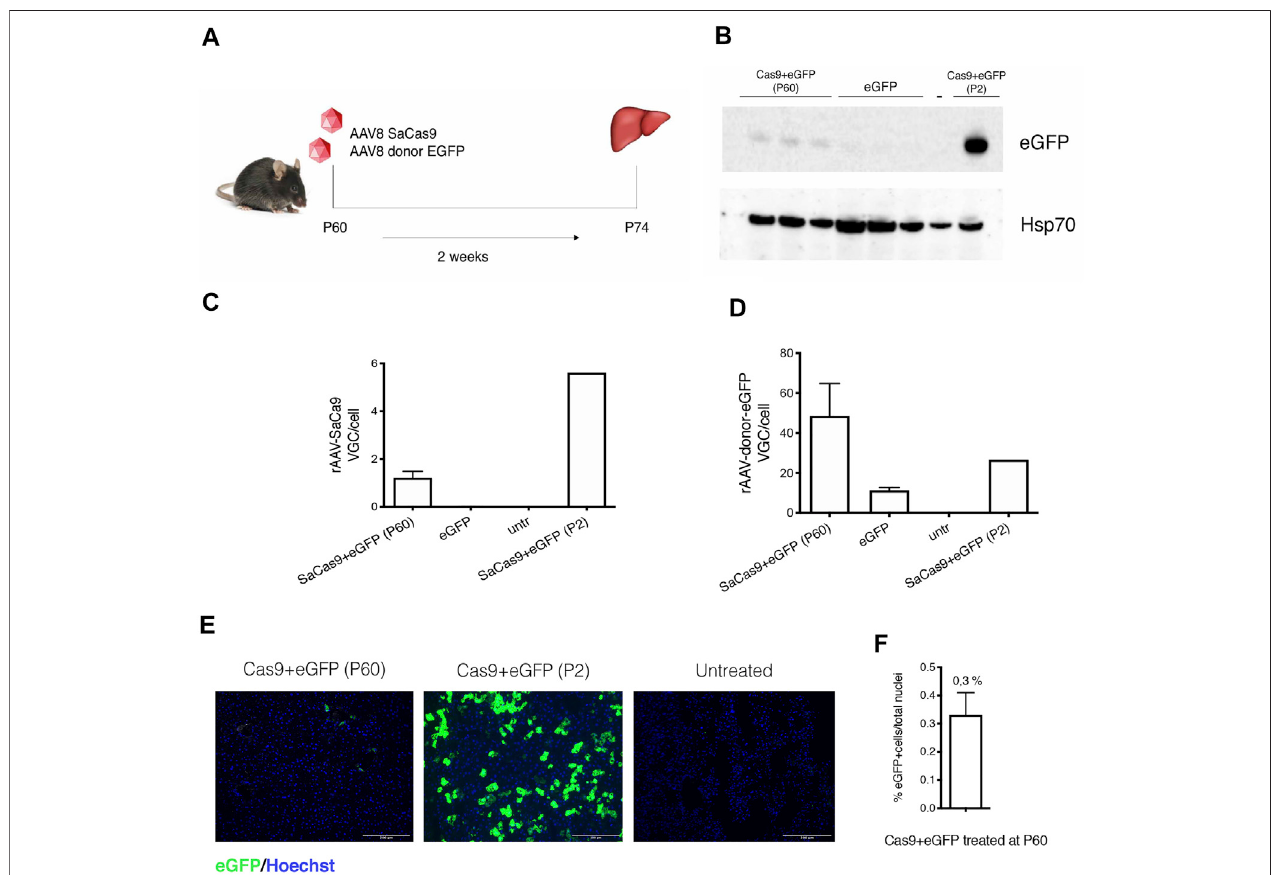
FIGURE 4 | Gene targeting in adult wild-type mice liver with a reporter donor-eGFP. (A) Experimental scheme. WT mice were transduced with AAV8-SaCas9 (1.0E11 vg/mouse) and AAV8-donor-EGFP (5.0E11 vg/mouse) at postnatal day (P) 60 and their livers were collected 2 weeks post-injection ( n = 3); (B) Western blot analysis of eGFP protein from liver extracts. In the analysis are included two samples from animals treated at P60 with donor-eGFP+Cas9, donor-eGFP (no Cas9), untreated wild-type mouse( − )andmousetreatedwithdonor-eGFP+Cas9atP2(+); (C,D) rAAV8-SaCas9andrAAV8-donor-eGFPviralgenomecopyanalysis; (E) ImmunohistochemicalanalysisofeGFPproteininmicetreatedwithSaCas9anddonor-eGFPatP60andP2.NucleiwerestainedwithHoechst(blue).Scalebar,200 μ m; (F) Quanti fi cation of eGFP-positive cells normalized by the total number of cell nuclei.